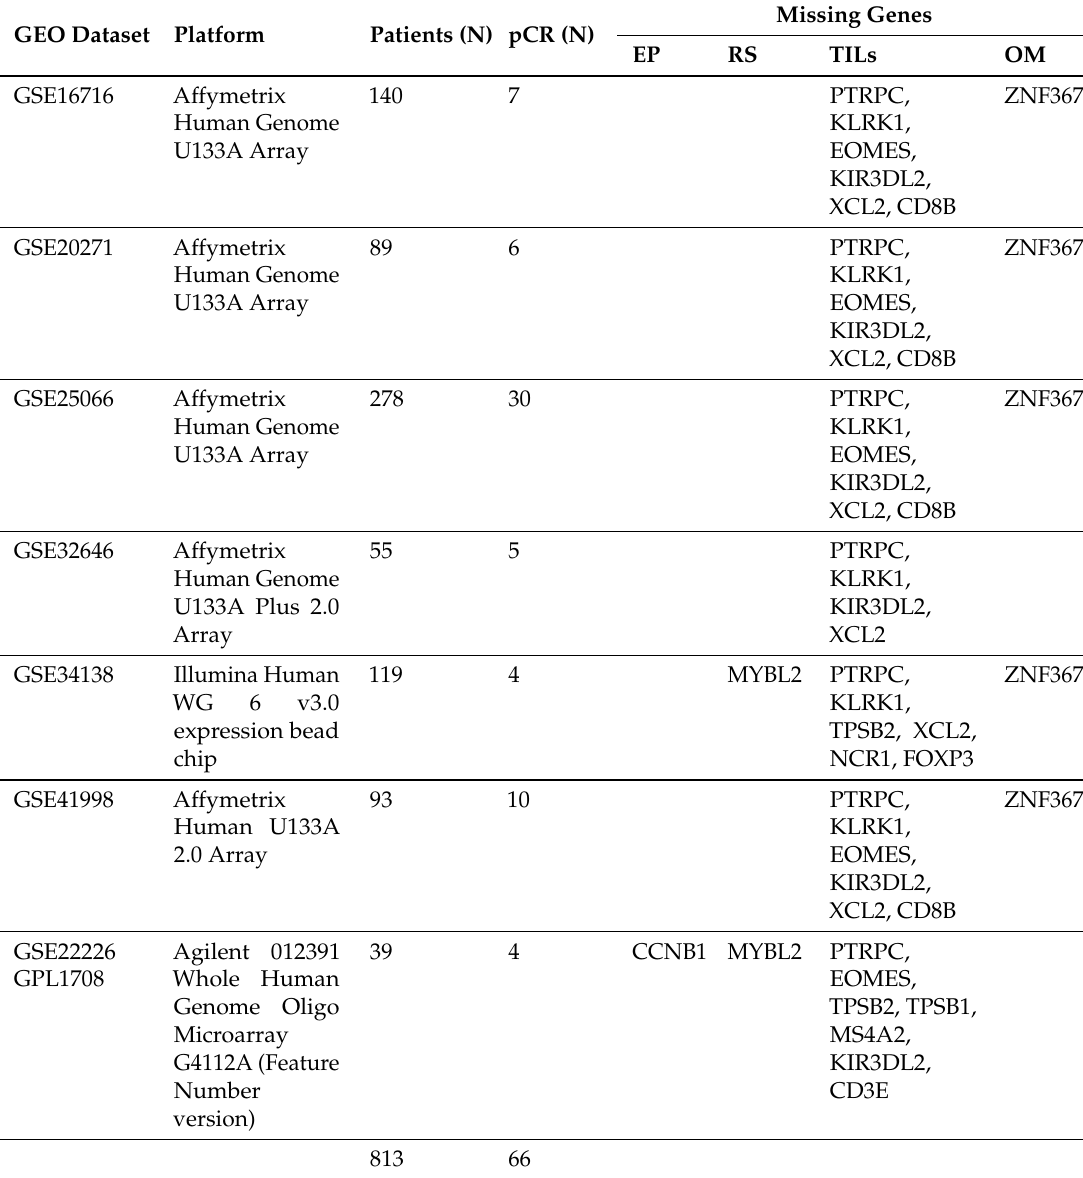
Table 1. GEO datasets included in the analysis